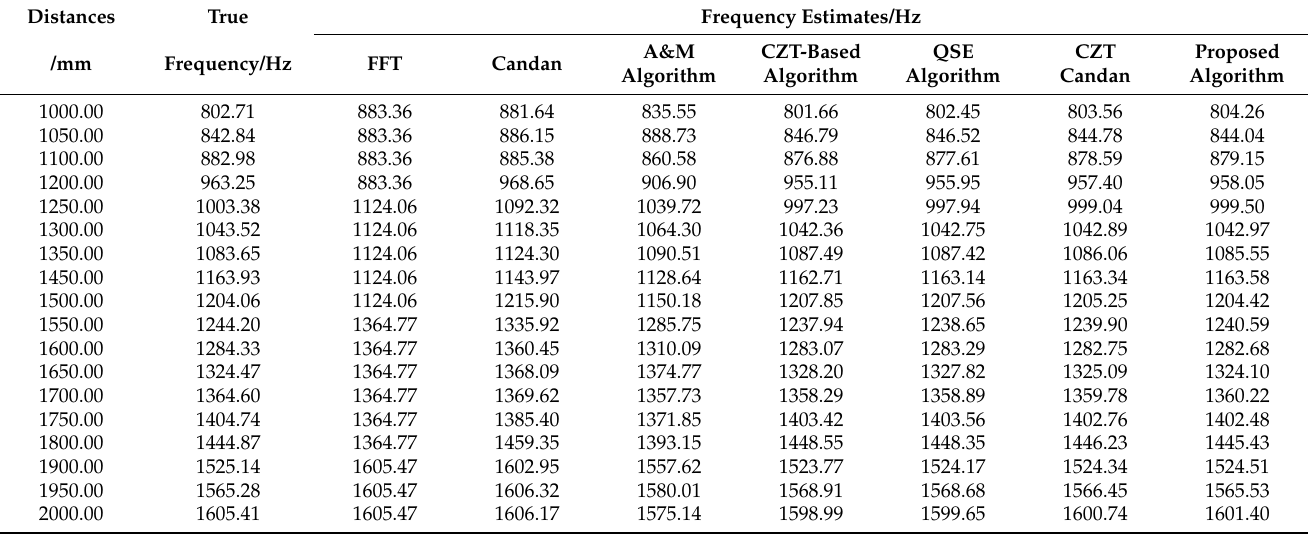
Table 5. Frequency estimates versus various distances and frequencies of the various